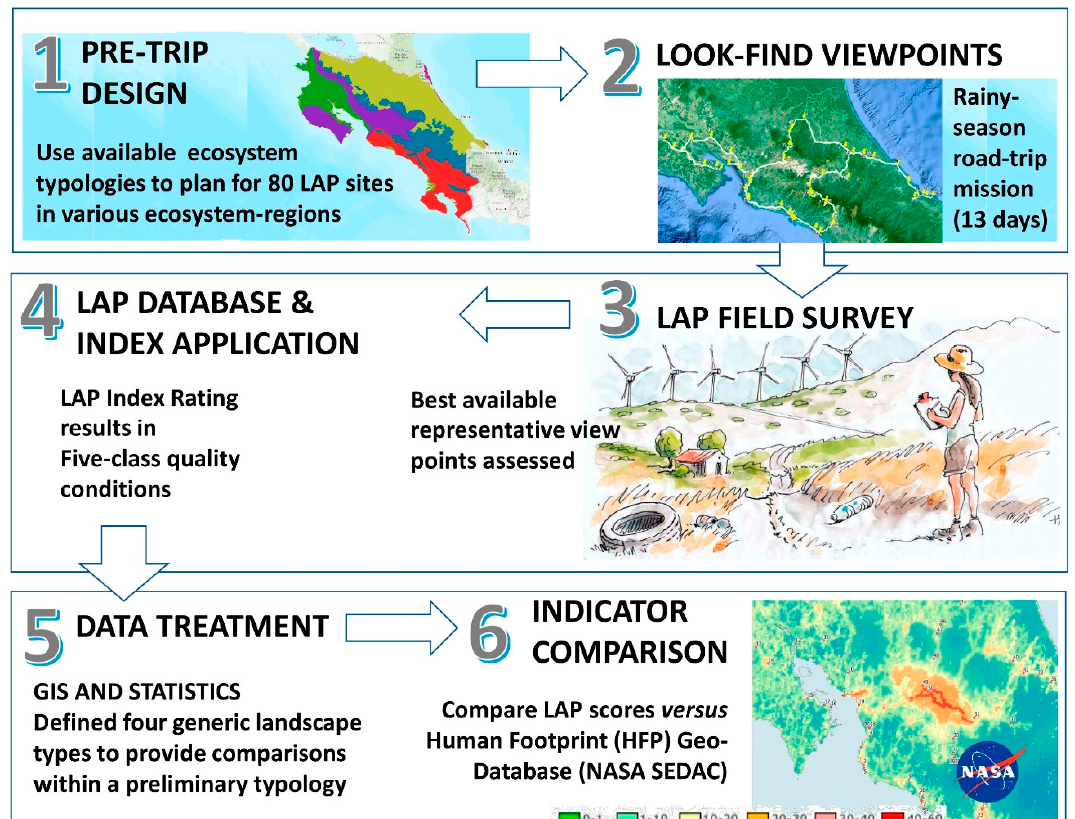
Figure 2. Summary of LAP application in Costa Rica: ( 1 ) designing the survey to cover different ecosystem types throughout the country; ( 2 ) searching for viewpoint possibilities to apply the LAP; ( 3 ) assessing selected landscape views onsite; ( 4 ) database, data entry, and index computation; ( 5 ) cartographical and statistical analysis; and, ( 6 ) insights from the results of other indicators. (Terrestrial ecoregion delineation (step 1) based on Olson and Dinnerstein 2001 [69], retrieved from https://databasin.org/ uploaded by http://consbio.org, accessed on 1 February 2022).